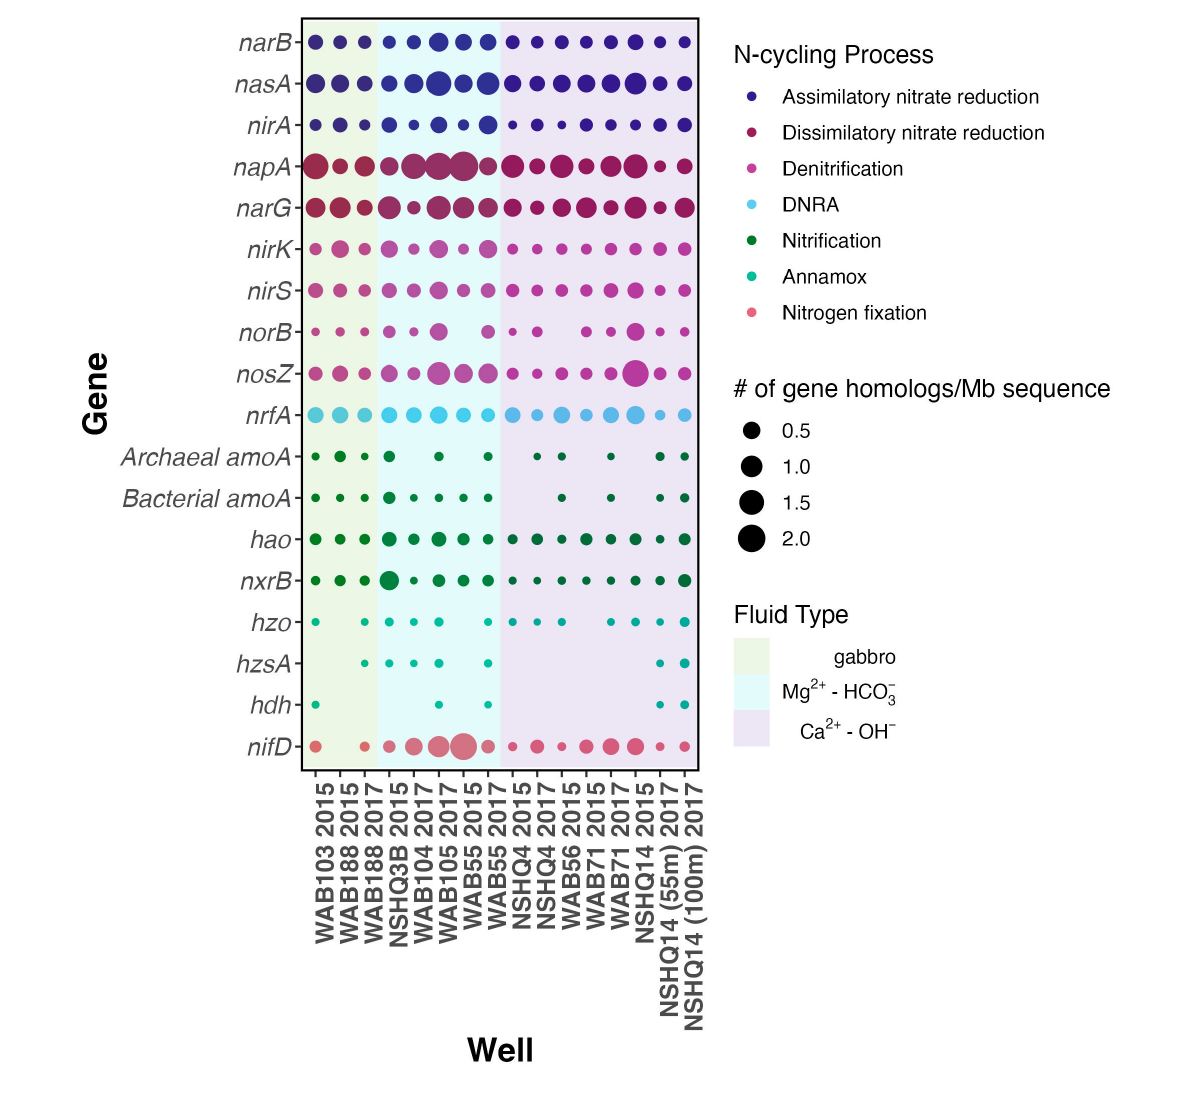
represents Ca 2 + -OH − fluids containing a greater proportion of nitrified NO − than Mg 2 + -HCO − 3 3